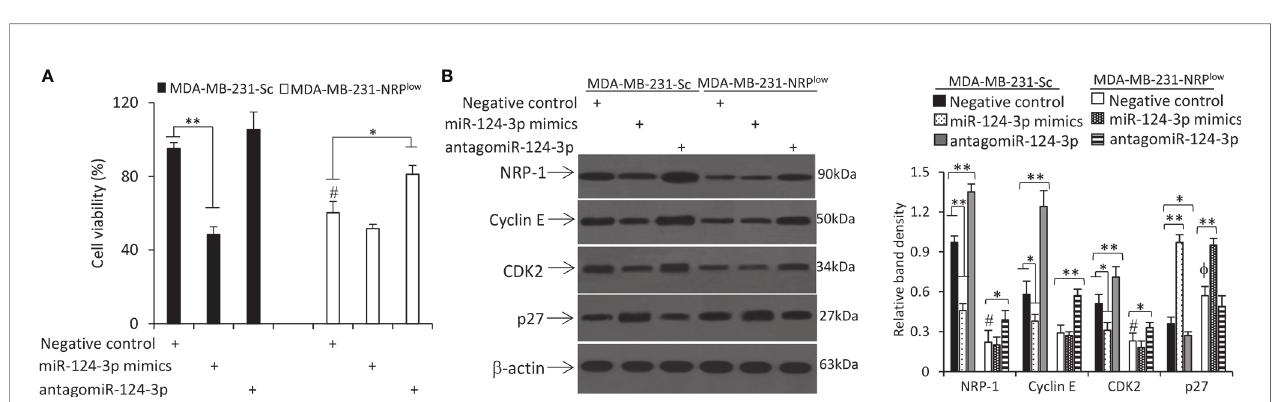
FIGURE 5 | MiR-124-3p inhibits cell proliferation by downregulating NRP-1. MDA-MB-231-Sc and MDA-MB-231-NRP low cells were transfected with negative control, miR-124-3p mimics or antagomiR-124-3p oligonucleotides and continued to be cultured for 48 h. (A) The viability of cells was detected by CCK-8 assay and normalized to mock-treated MDA-MB-231-Sc cells. (B) Cells were lysed and subjected to Western blot analysis. Band density was normalized to b -actin. “ * ” (P<0.05) and “ ** ” (P < 0.001) indicate a signi fi cant difference. A one-way ANOVA with a Tukey post-hoc test was used for statistical analysis. “ f P < 0.05 ” indicates a signi fi cant increase, while “ # P < 0.05 ” , a signi fi cant reduction, compared with negative control-treated MDA-MB-231-Sc